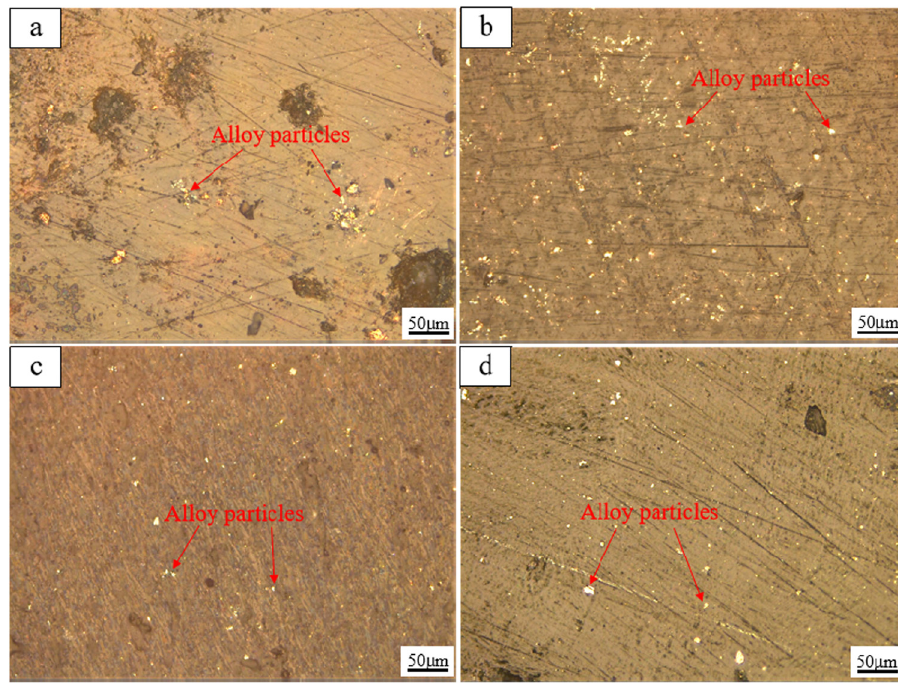
Figure 10: Metallographic photographs ( 200 ×) of the slags obtained with di ff erent R ( C/A ) ( a: 0, b: 0.2, c: 0.6, and d: 1.0 )